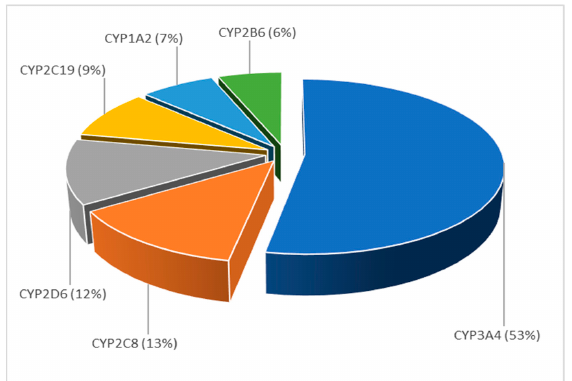
Figure 16. Distribution of published PBPK models in relation to the key analyzed CYP 450 enzyme within topic 4, expressed as frequency (%), normalized to 100%. Further, the utilization of PBPK modeling for the prediction of transporter-mediated DDIs was investigated, by extracting all publications that contained the word “trans- porter”. The extract keyword widget showed that frequently mentioned words within the subcorpus “transporter” are “intestinal”, “renal”, “liver”, and “clearance” indicating that most of the articles discuss utilization of PBPK modeling for the prediction of DDIs medi- ated by the transporters in the liver (32%), kidneys (20%) and intestine (17%). Figure 17